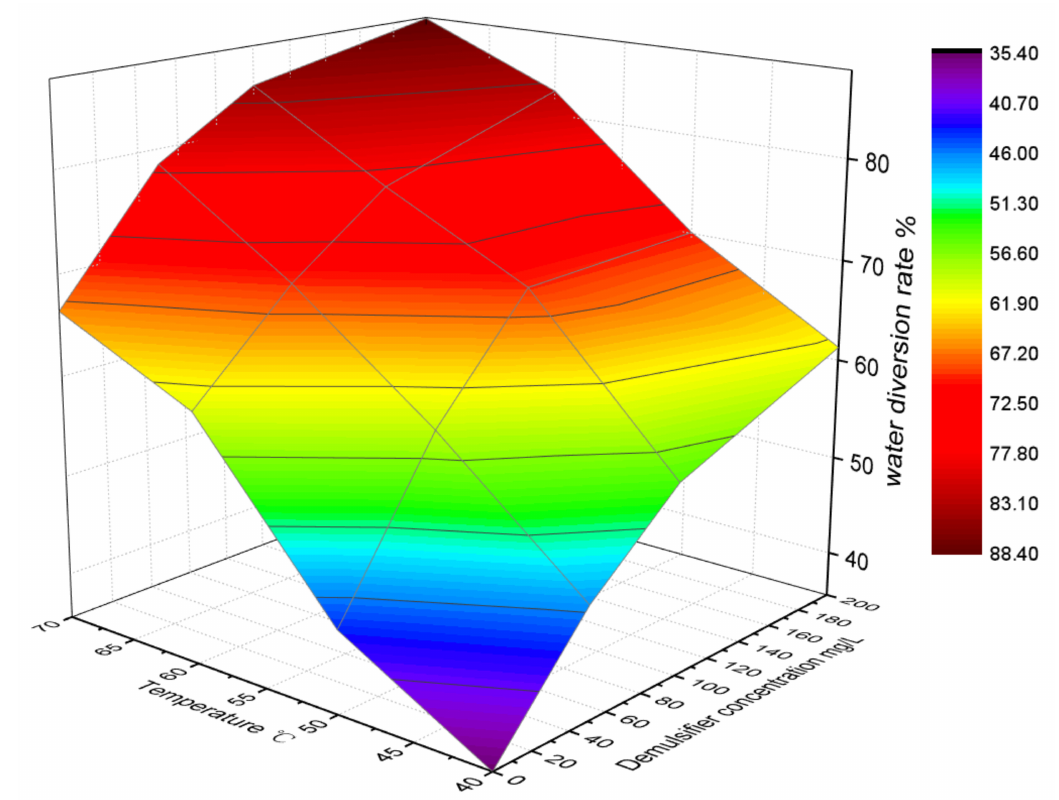
Figure 7. Effect of temperature and demulsifier concentration on WF